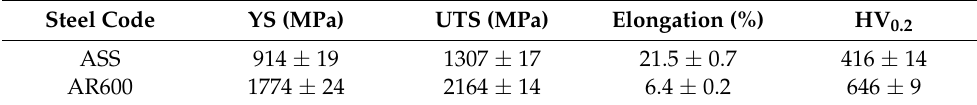
Table 2. Mechanical properties of the experimental base metals under quasi-static tensile tests. Steel Code YS